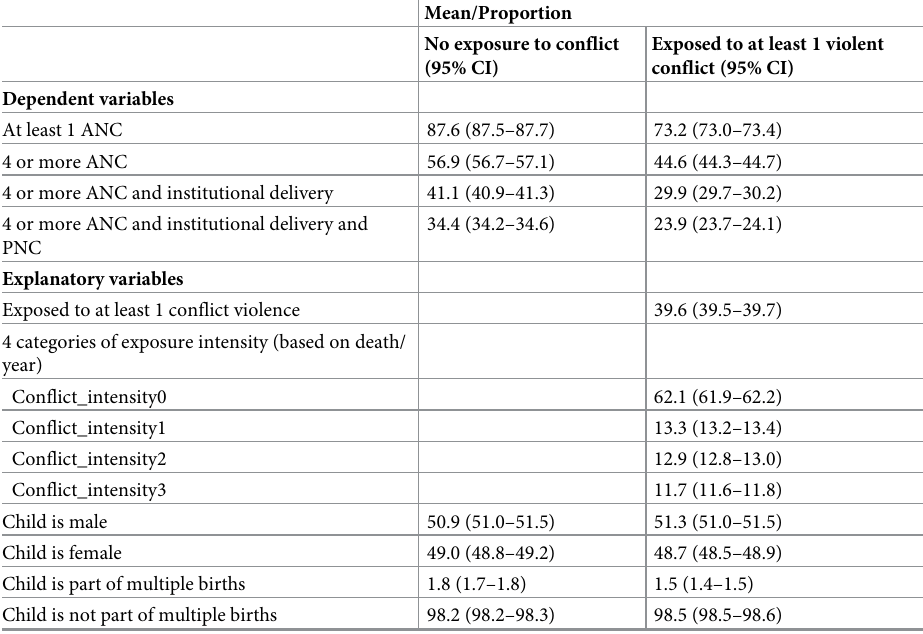
Table 2. Descriptive statistics of the study